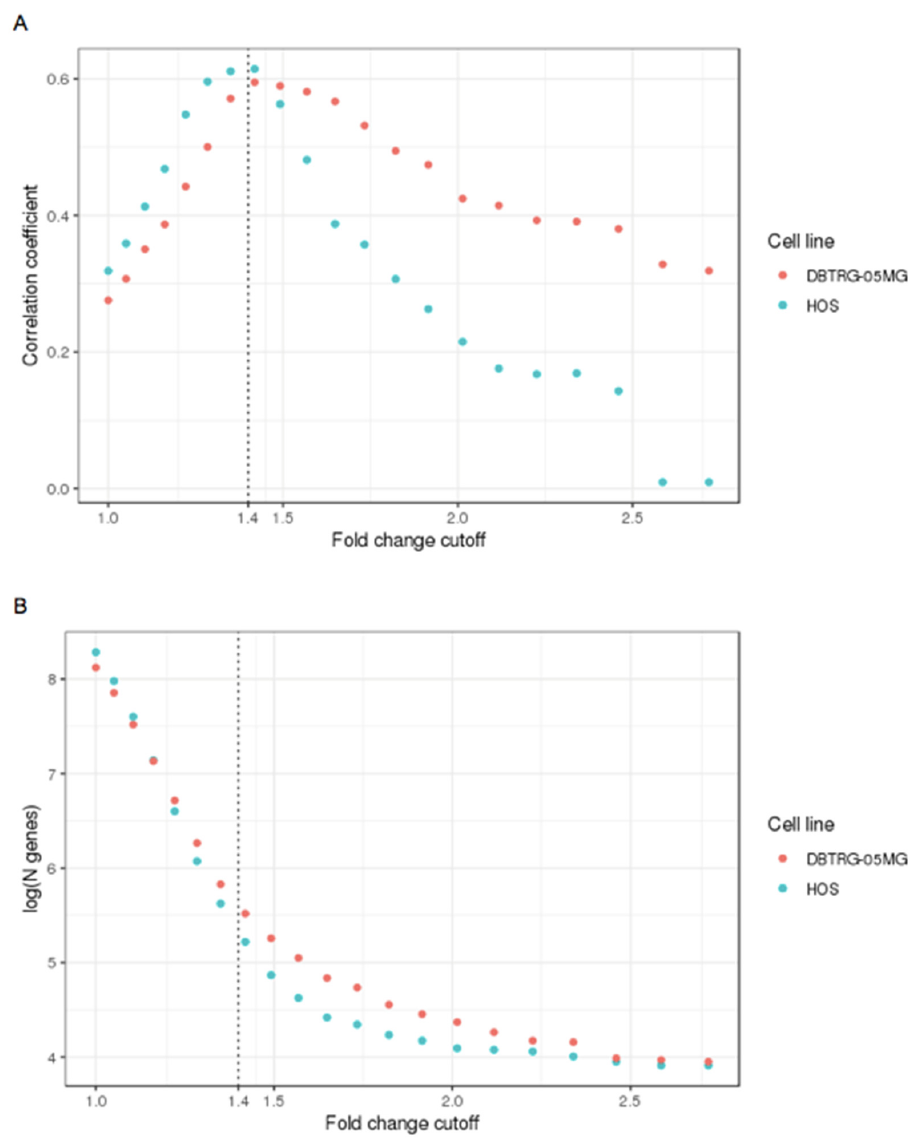
Figure 5. A graphical demonstration of the approach to determining the fold-change cut-off for differentially expressed proteins in DBTRG-05MG and HOS cell lines under type I interferon treatment. Pearson correlation between logFC values obtained by RNA-seq and label-free quantitative proteomics when using gradually varying cut-offs for RNA-seq fold change values ( A ). Amounts of genes are differentially expressed in HOS and DBTRG-05MG cell lines depending on RNA-seq fold change cut-off ( B ).